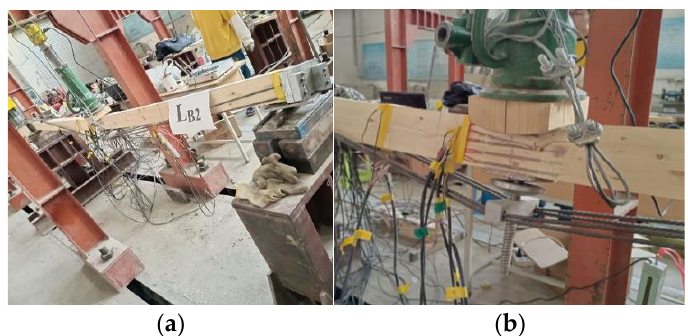
Figure 11. Overall instability failure. ( a ) Overall instability; ( b ) Instability position.